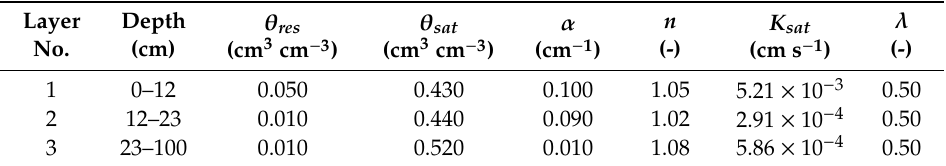
Table 5. Calibrated Mualem–van Genuchten parameters.